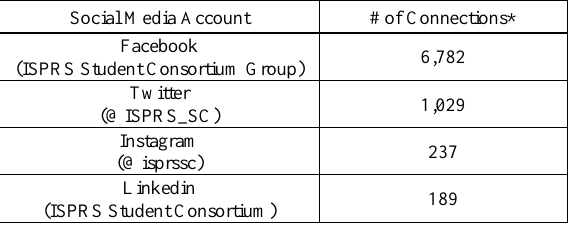
Table 1. The number of connections of the ISPRS SC